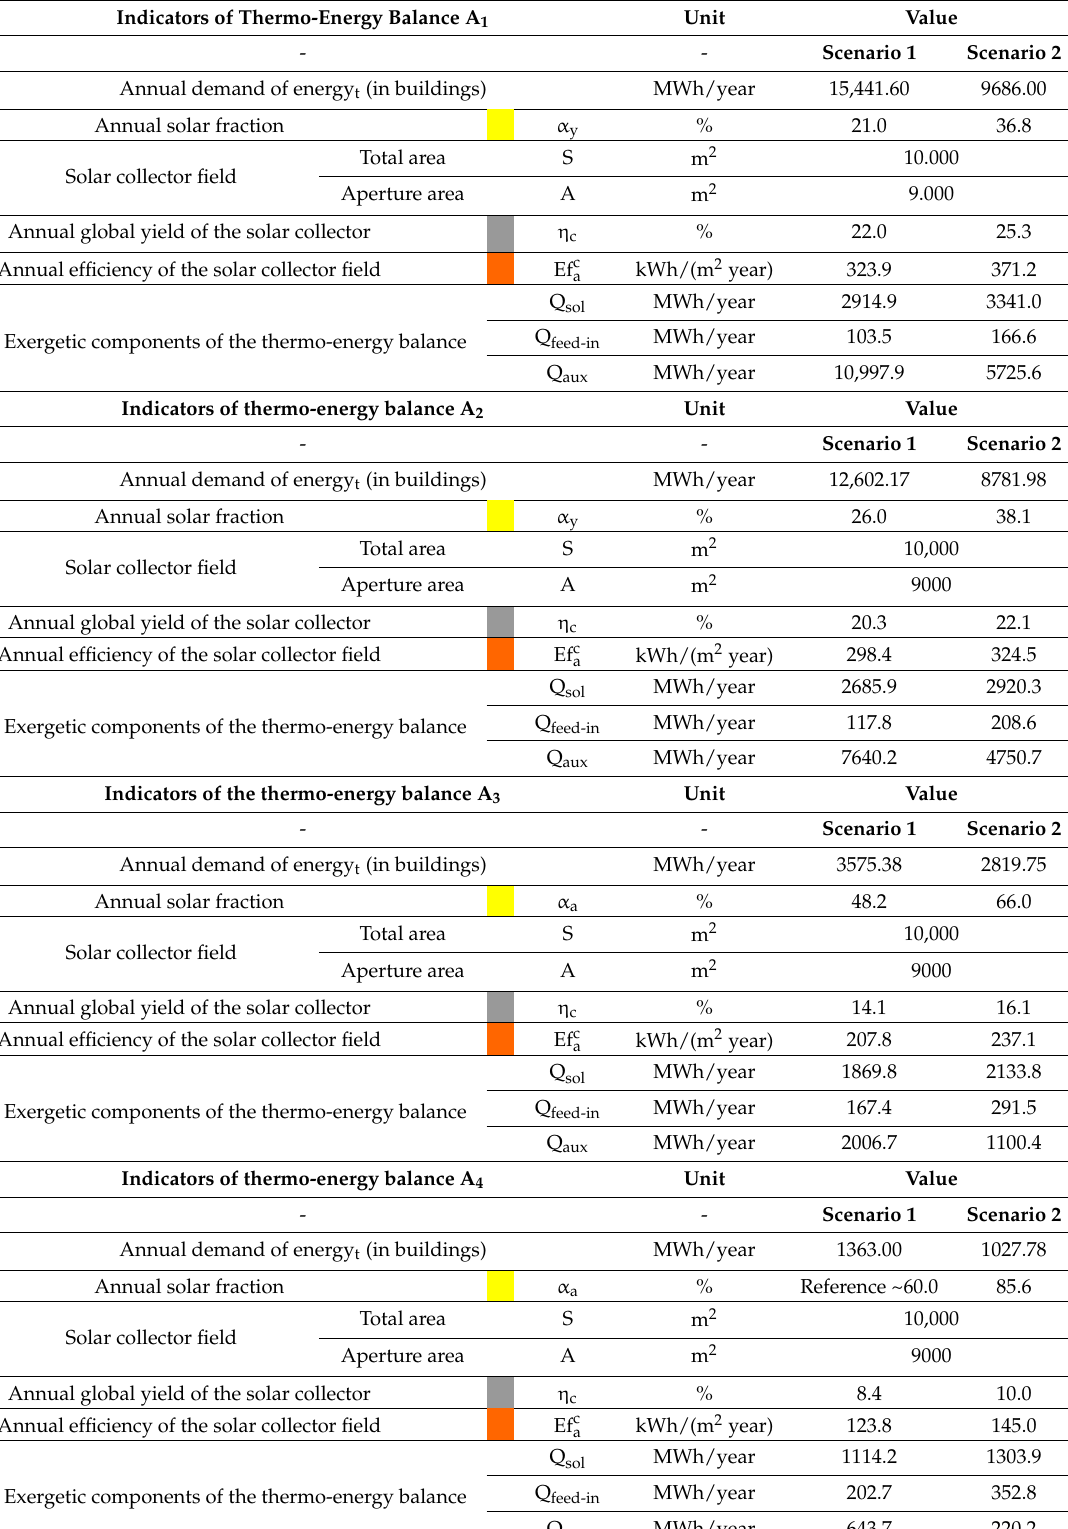
Table 8. Indicators of the thermo-energy balance A 1 –A 4